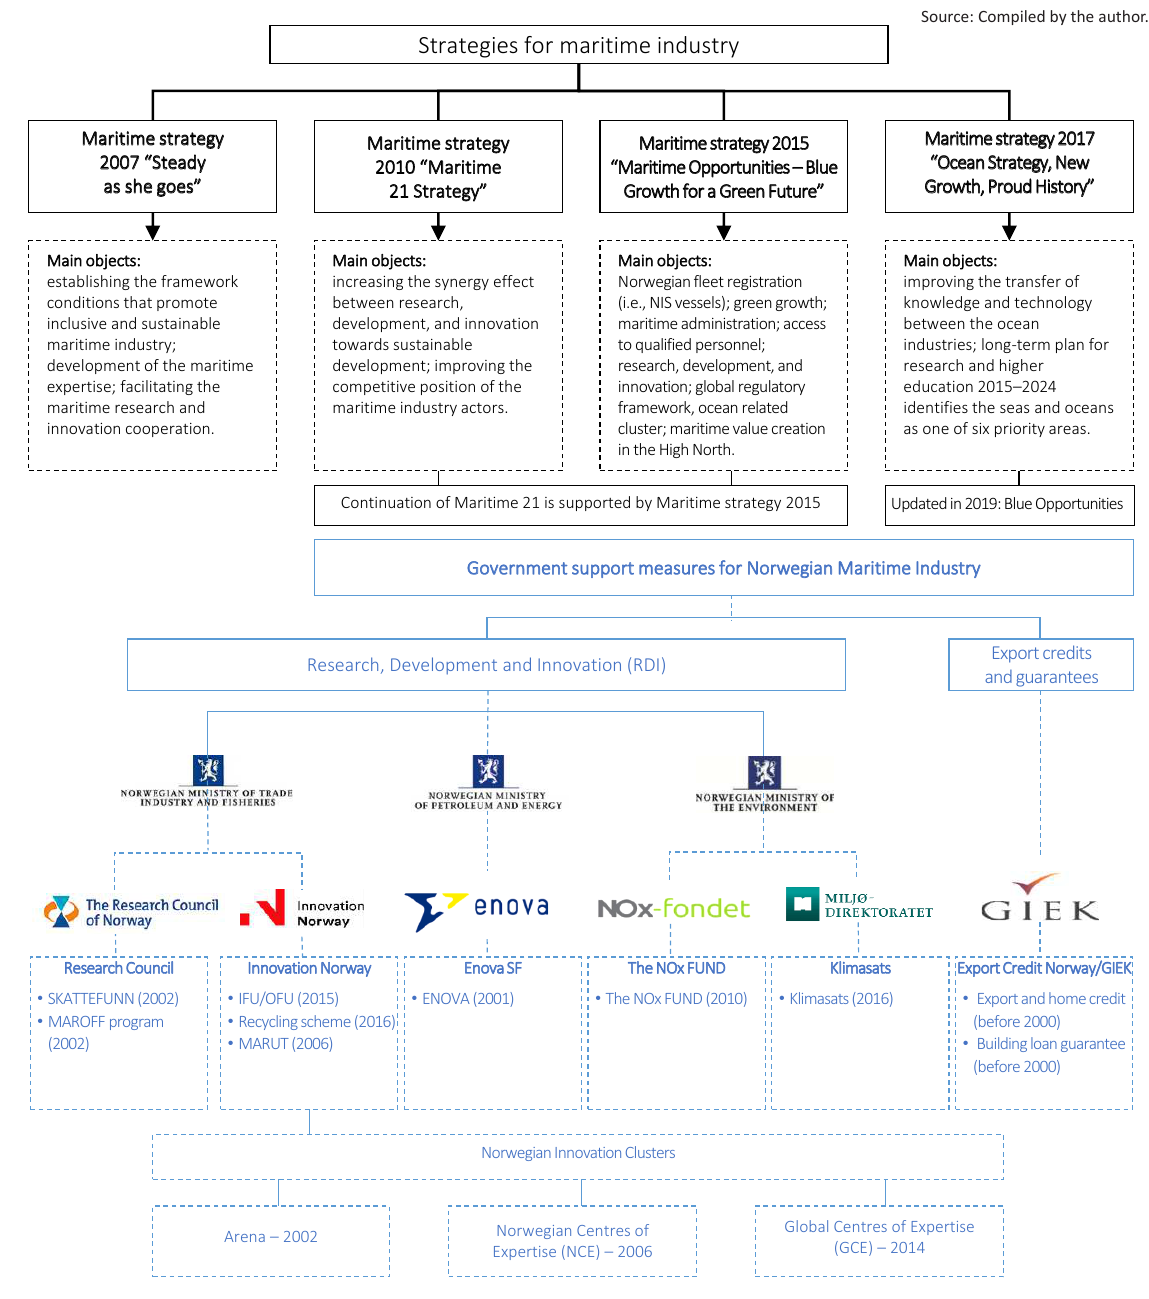
Figure 1. Norway’s maritime strategies and government support